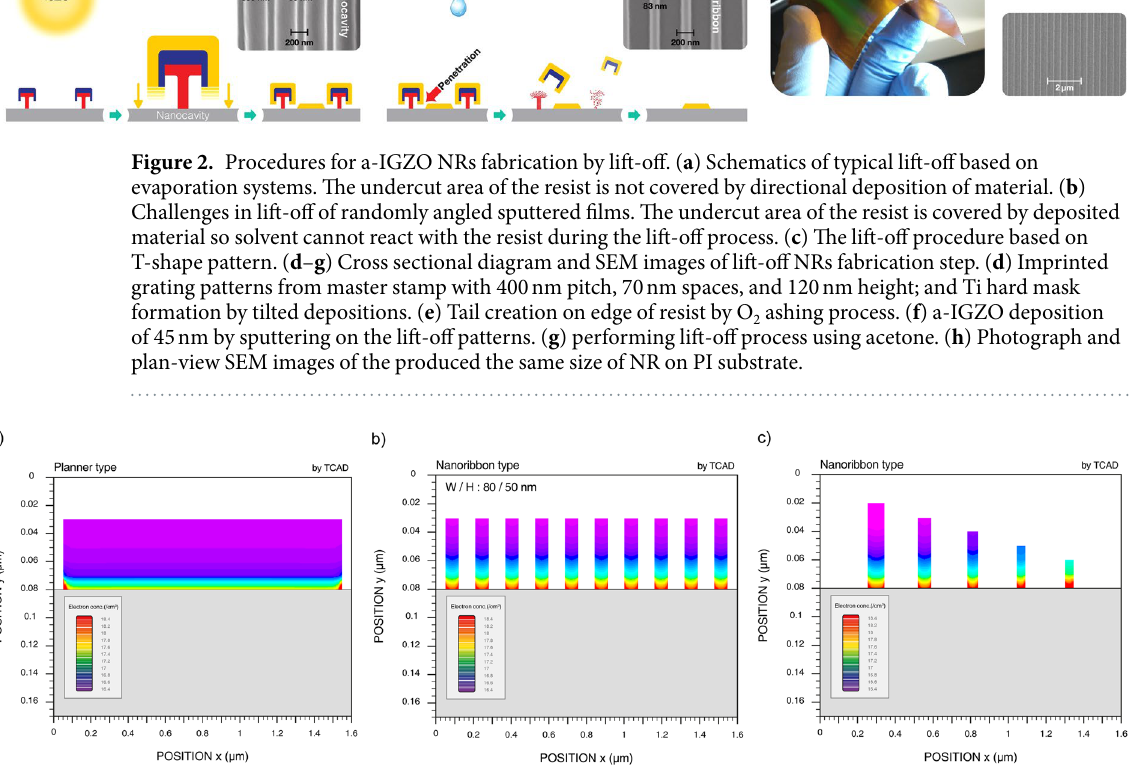
Figure 3. TCAD simulation of cross-sectional distribution of electron density in ( a ) planar and ( b ) NR channel with the same thickness viewed from the (source or drain) electrode. ( c ) Comparison in electron density distribution of the single NR in different sizes. Electron concentration increases as NRs shrink, as shown by the red color moving